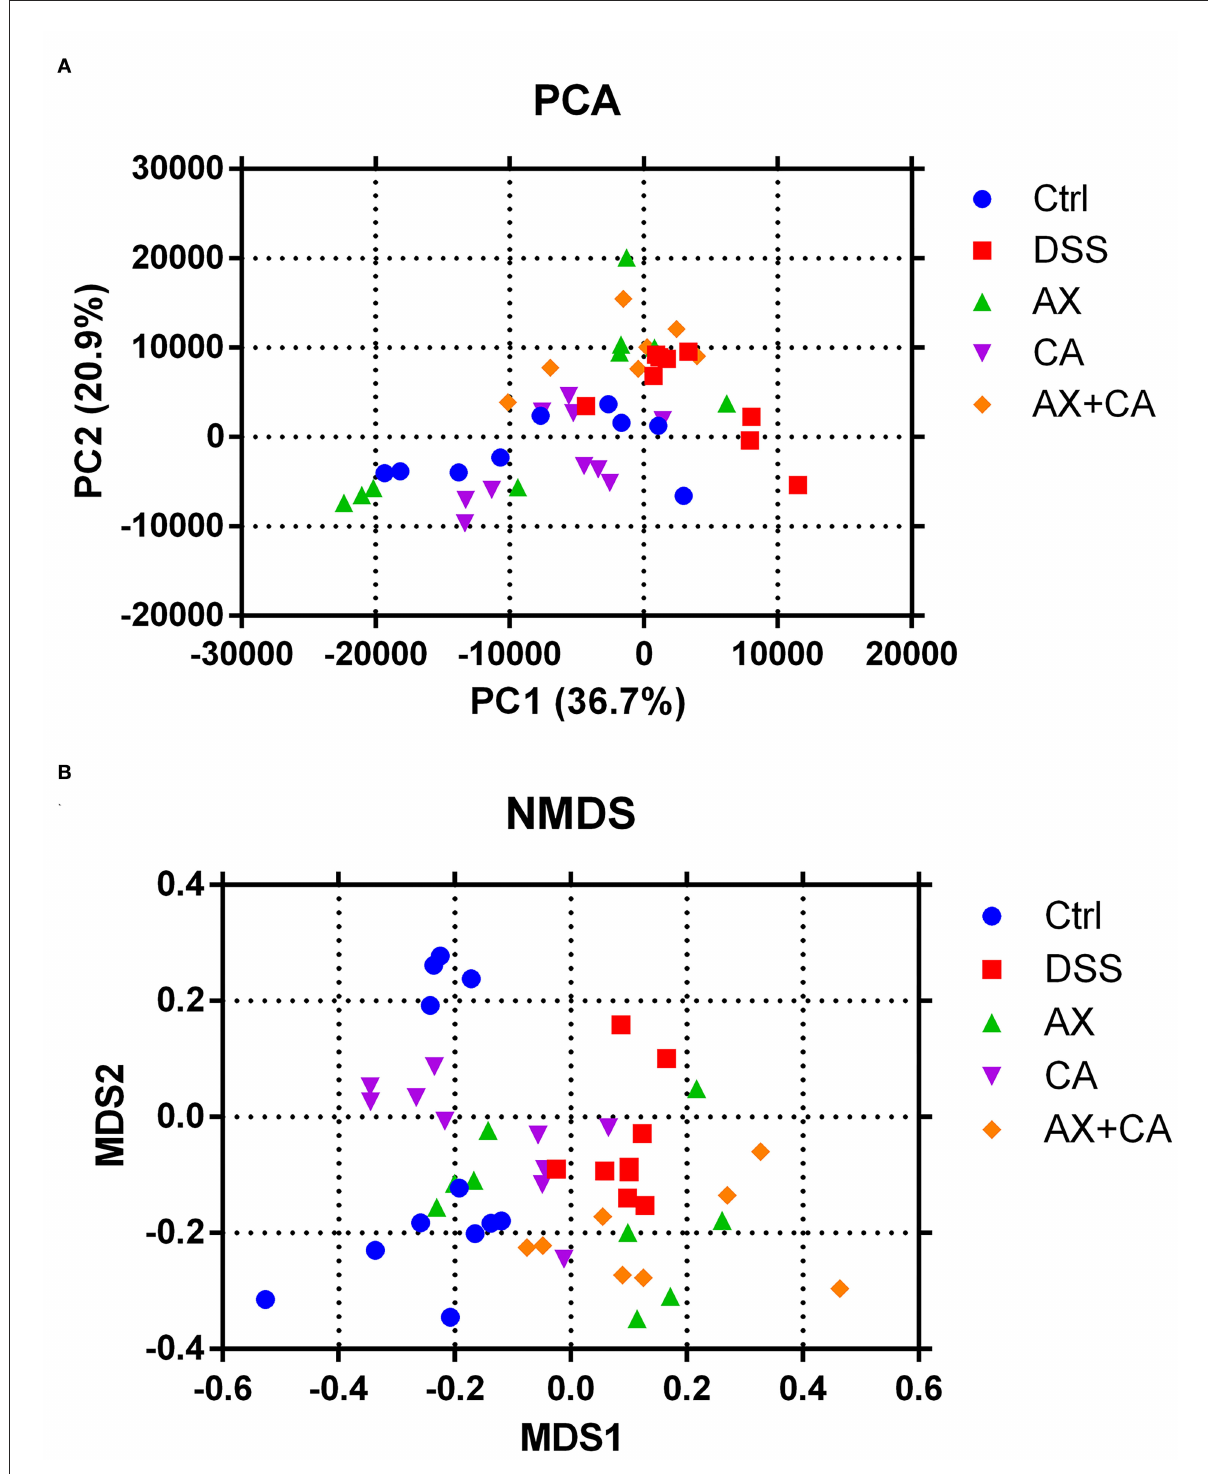
FIGURE4 Beta-diversity of intestinal microbiota [ (A) PCA; (B)